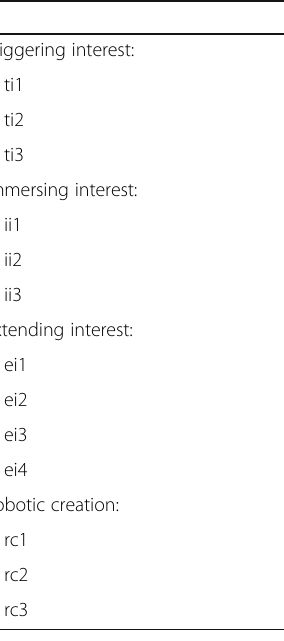
Table 4 R 2 for the theoretical